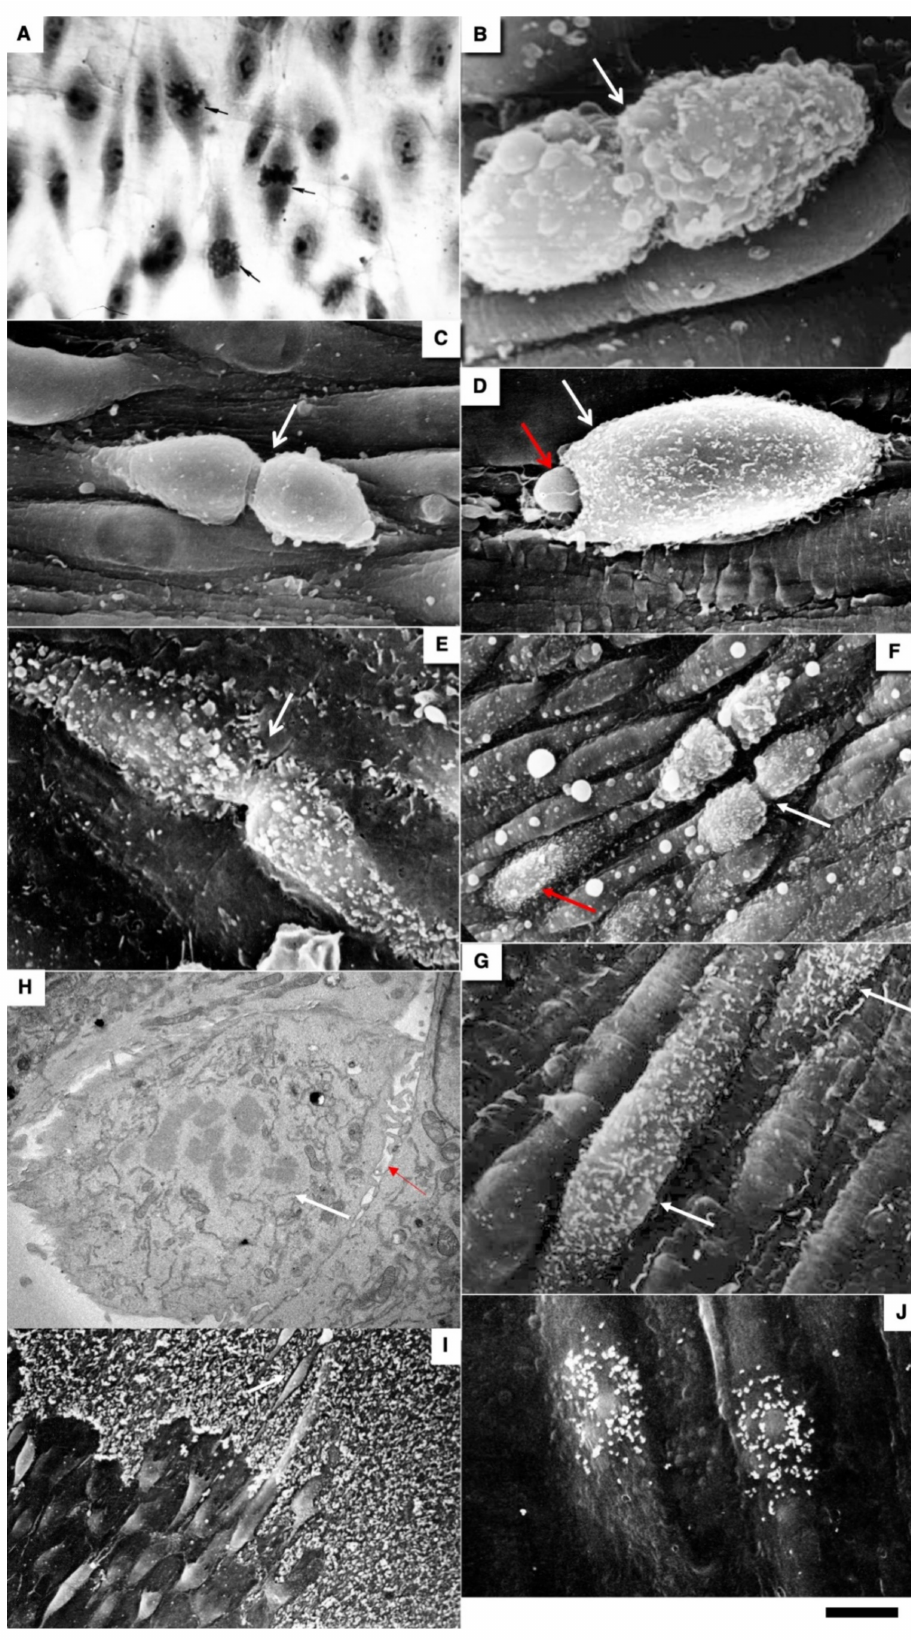
Figure 4. Mitotic activity of ECs during regeneration. ( A ) Flat en-face preparation of the EC monolayer. Light microscopy. Arrows show ECs in mitosis. ( B – G ) Different types of mitosis. Scanning